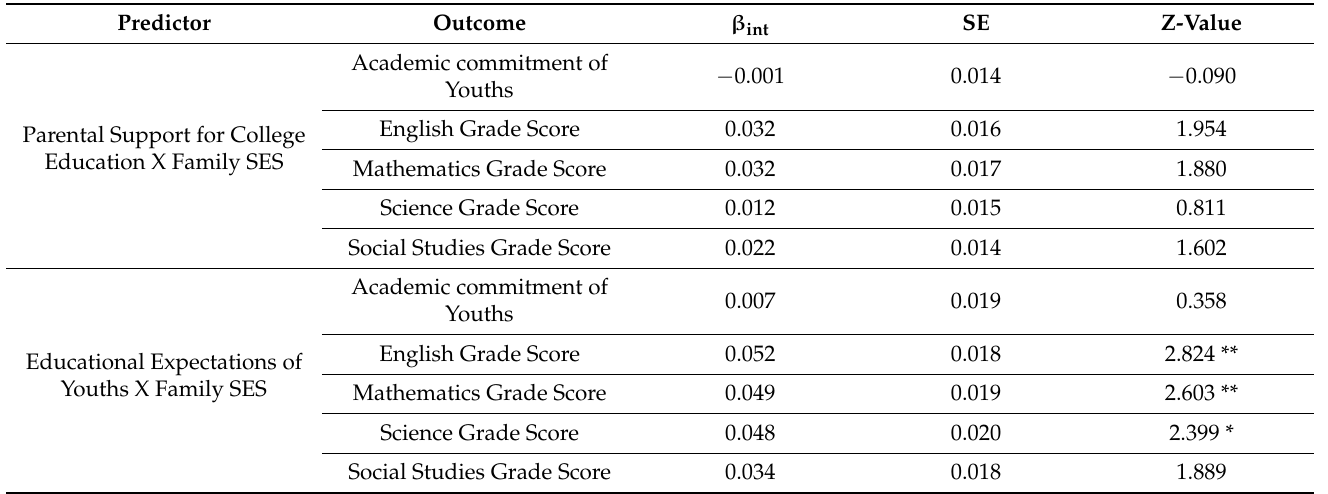
Table 3. Moderated Effects of Parental Support for College Education and Educational Expectations of Youths by Family SES in Grade 7 on Youths’ Grade-8 Academic Commitment and Grade-9 Educational Performance (Model 1).